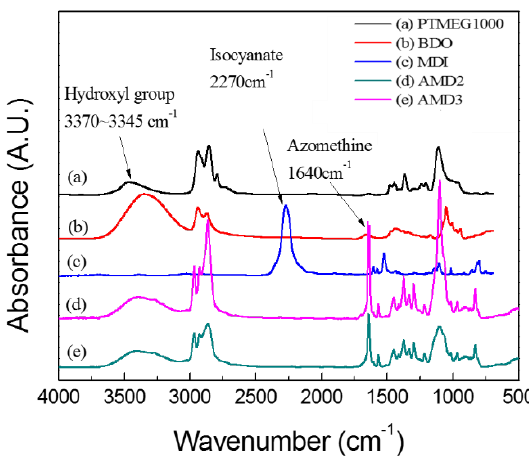
Figure 1. FT-IR spectra of raw materials and synthesized AMDs.